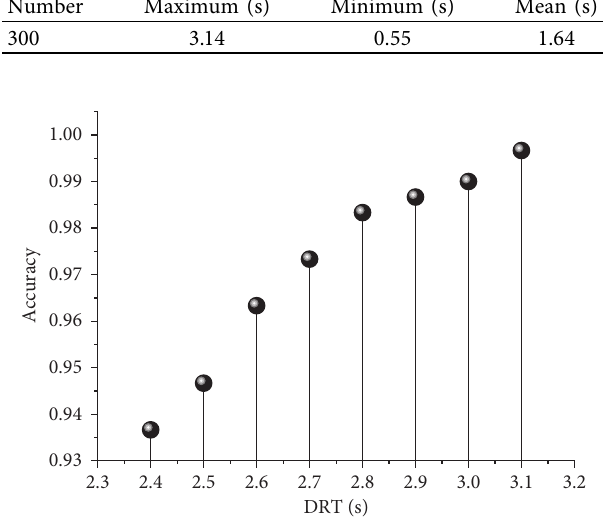
Figure 7: The relationship between the DRTand the accuracy rate.